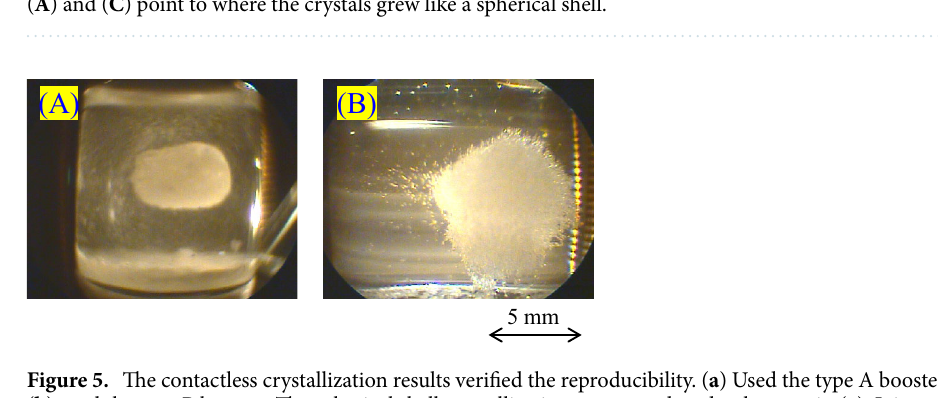
Figure 4. The spherical crystal photographed after the experiment. The crystal sphere was a polycrystal of HEWL. ( A ) Provides the evidence that the crystal was hollow inside (see the blue arrow). The black arrows in ( A ) and ( C ) point to where the crystals grew like a spherical shell.